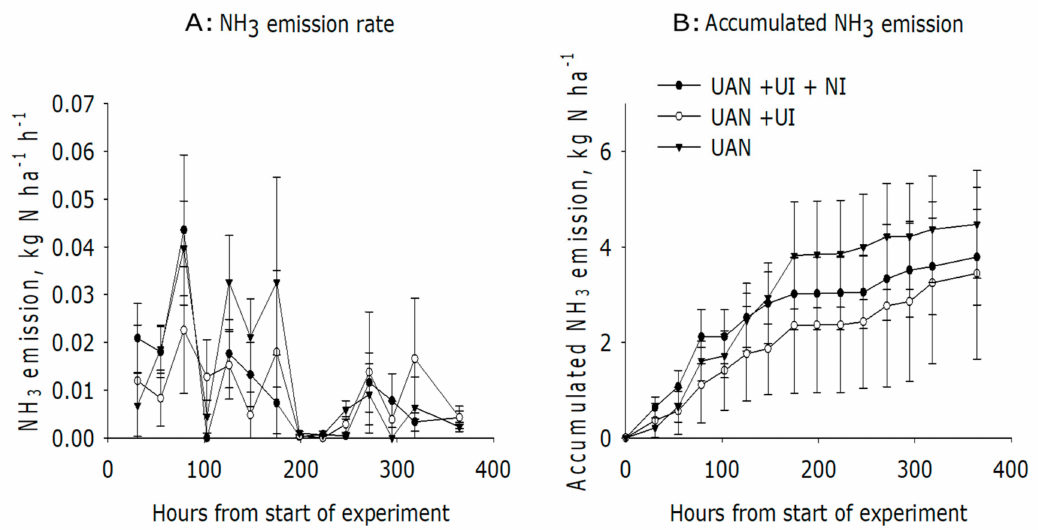
Figure 3. Experiment two where NH 3 emission was measured in April. A: NH 3 emission rates. B: accumulated NH 3 emission (B). The treatments were UAN; UAN without additives, UAN + UI; UAN mixed with urease inhibitor (UI) or UAN + UI + NI; UAN mixed with UI and nitrification inhibitor (NI). (Error bars: SE, n =